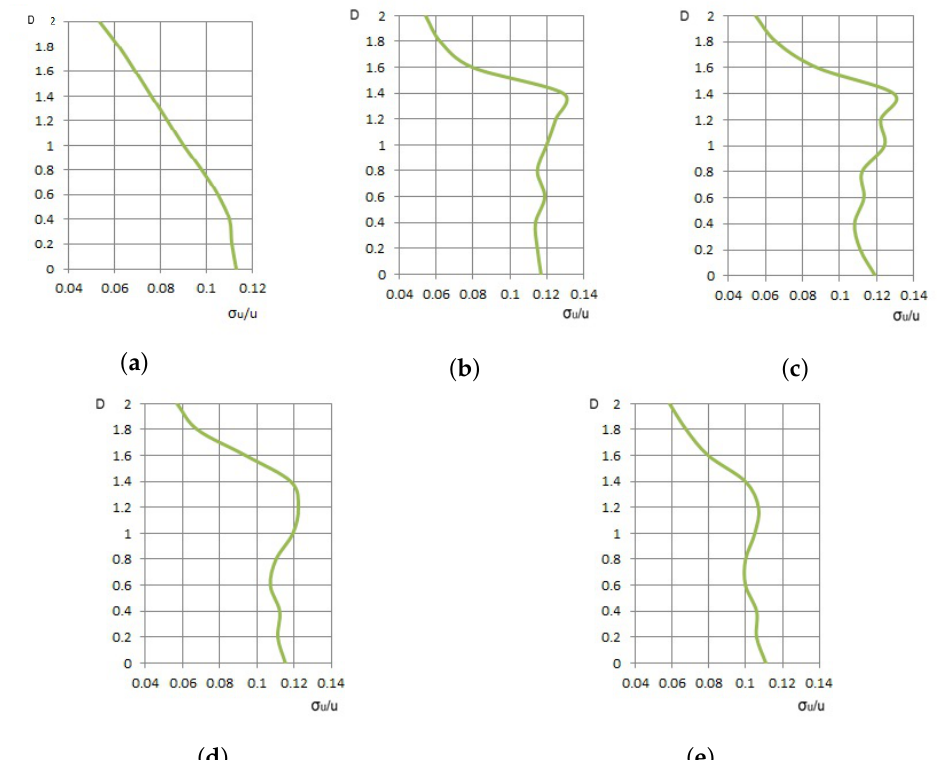
Figure 10. Profile of the turbulent intensity in the wind turbine zone: ( a ) intensity of turbulence before the wind turbine; ( b ) intensity of turbulence behind the wind generator at D = 2; ( c ) the intensity of turbulence behind the wind generator at D = 4; ( d ) the intensity of turbulence behind the wind generator at D = 6; ( e ) the intensity of turbulence behind the wind generator at D = 8.